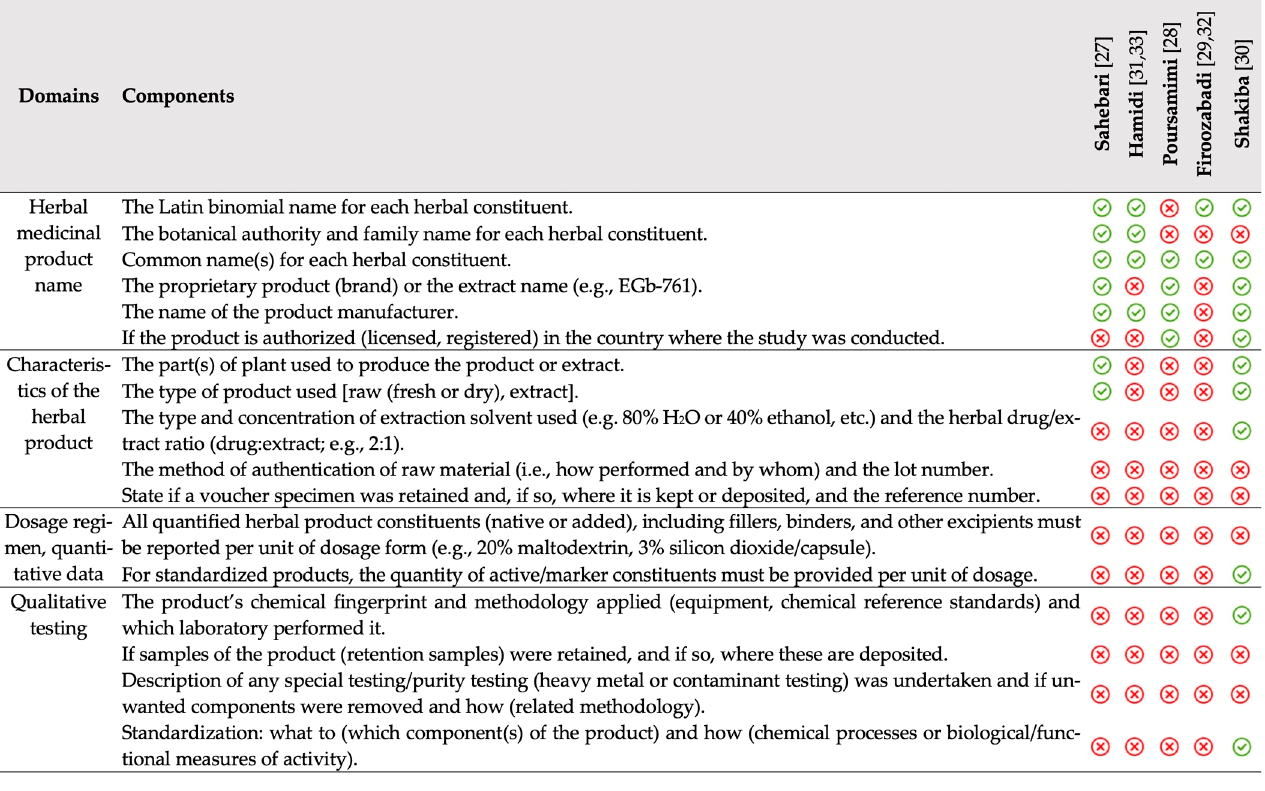
Figure 5. Summary of adherence to the formula elaborations suggested by the CONSORT statement for RCTs implementing herbal medicine interventions [17]. CONSORT, Consolidated Standards of Reporting Trials; RCT, randomized controlled trial.